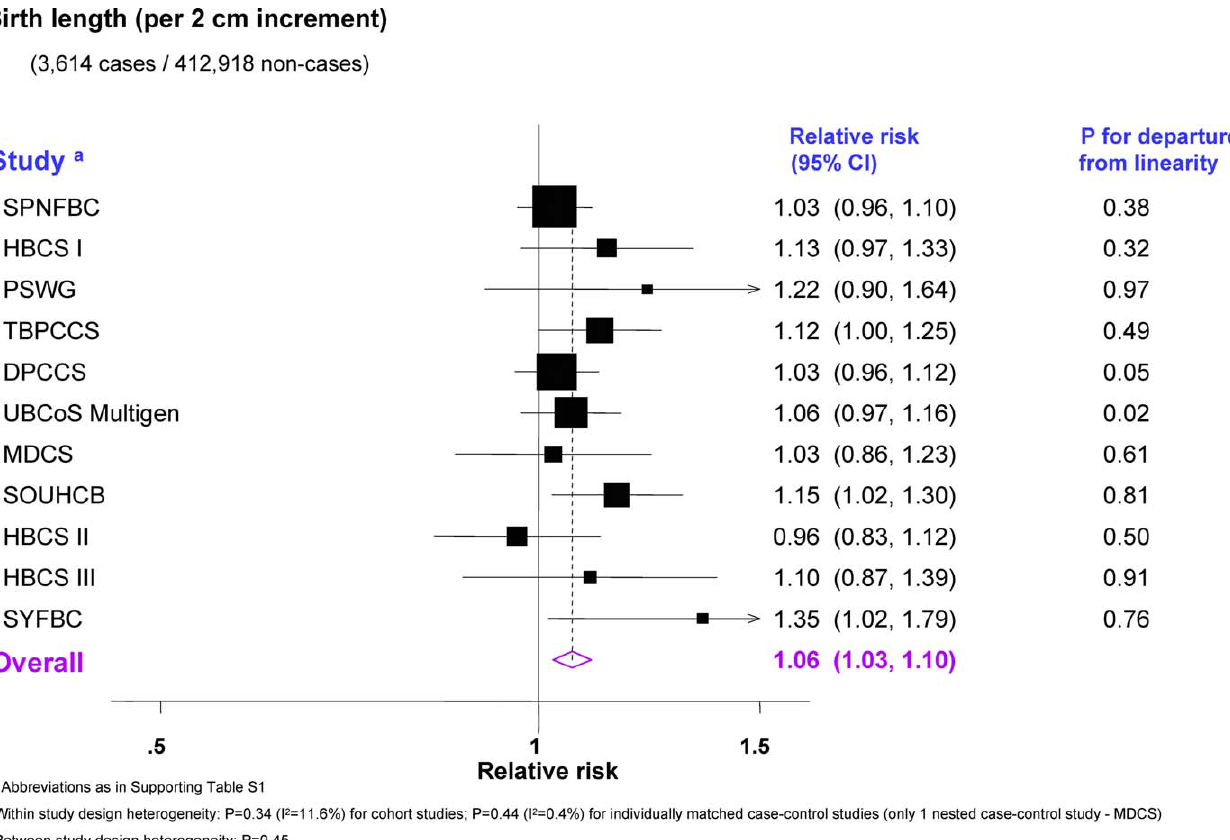
Figure 4. Minimally Adjusted Study-Specific and Pooled Breast Cancer RRs in Relation to Continuous Birth Length (Singleton Studies Only) The area of the black squares is inversely proportional to the variance (on the log scale).